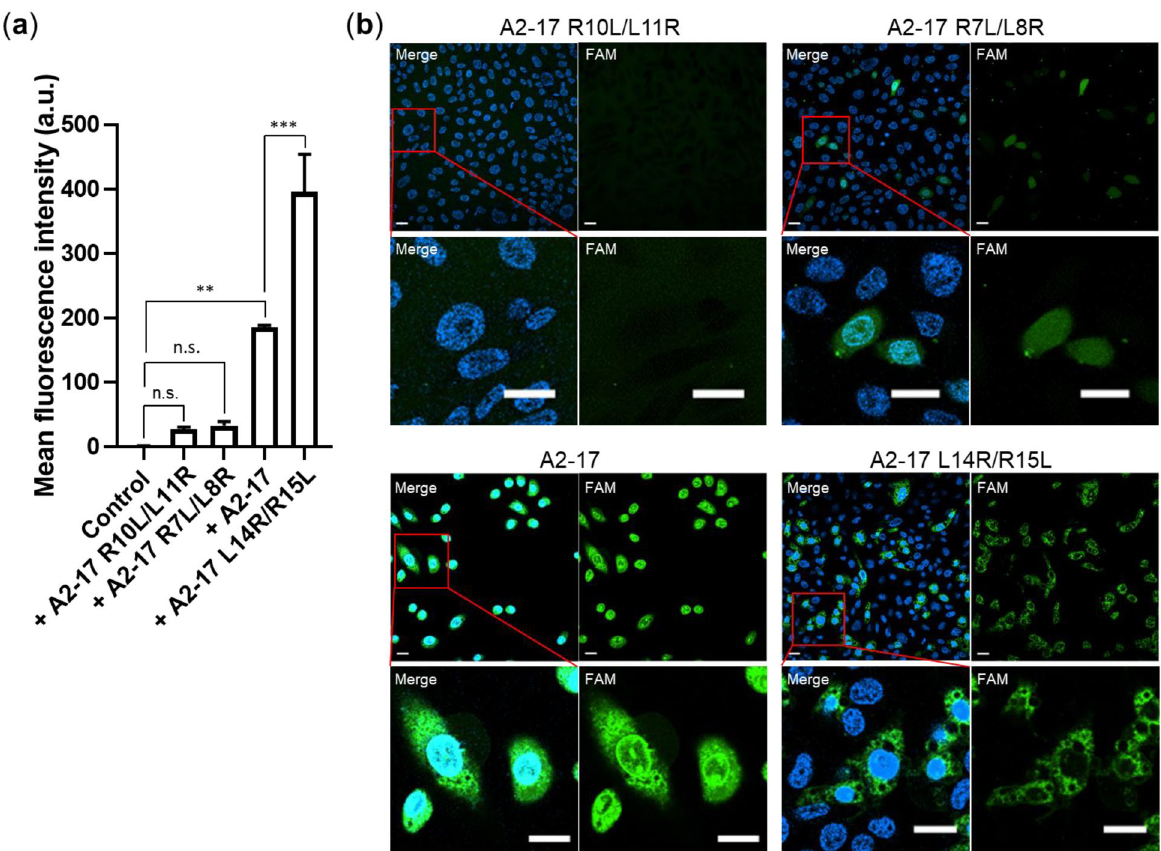
Figure 3. Analysis of cell membrane penetration of A2-17 structural isomers. ( a ) Flow cytometric quantification of the amount of cell-associated (membrane-bound and internalized) peptide in CHO-K1 cells treated with 2 µM of FAM-labeled peptides for 30 min at 4 °C. ** p < 0.01; *** p < 0.001; n.s., not significant. ( b ) Confocal fluorescent images of CHO-K1 cells treated with 2 µM of FAM-labeled peptides for 30 min at 4 °C. FAM fluorescence (green) and Hoechst fluorescence (blue) counterstaining nuclei are shown in the merge image (Merge) along with the image of FAM fluorescence (FAM). The scale bars represent 20